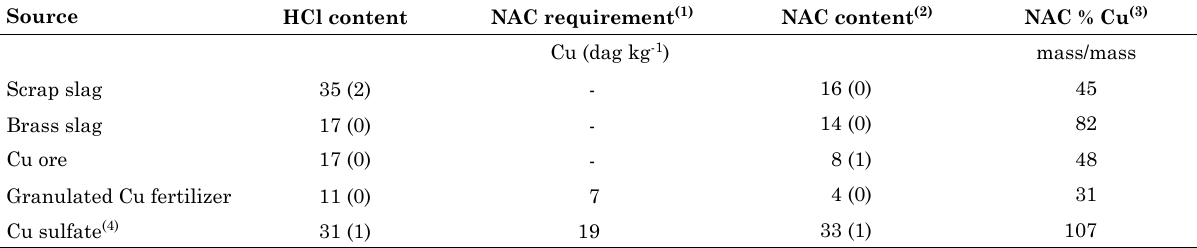
Table 4. Mean Cu values and standard deviation, in parentheses, extracted with NAC + water (1:1) solution, and in relation to the weight and the content of HCl in industrial by-products and mineral fertilizers Source HCl